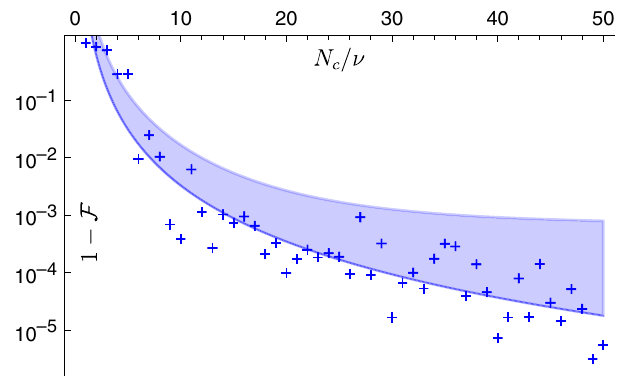
FIG. 3. Performance improvement when we increase the number of constraints N illustrated on a 14-qubit recompilation c problem of “ rediscovering ” unknown parameters ( ν ¼ 124 ) of an Ansatz (refer to Sec. IVA for more details). CoVaR is run for a fixed number 20 of iterations (initial average fidelity F ¼ 46 (cid:4) 7% ), and the final achieved infidelity 1 − F with respect to the ground state is reported: Blue crosses show the best of three runs of CoVaR, and we plot their fit with the function a ð N = ν Þ − b þ c (blue curve) as we detail in Appendix E 1. The c worst of three runs are also fitted with the same function (blue shade), confirming a polynomially (in N ) increasing perfor- c mance with b ≈ 3 . 2 — although we expect this degree to depend on the problem. The large spread of data points is due to our randomly generated constraints (with respect to 3-local Pauli strings).